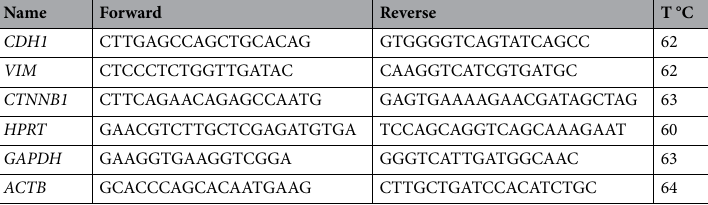
Table 2. Primers used in this study to evaluate gene expression by quantitative